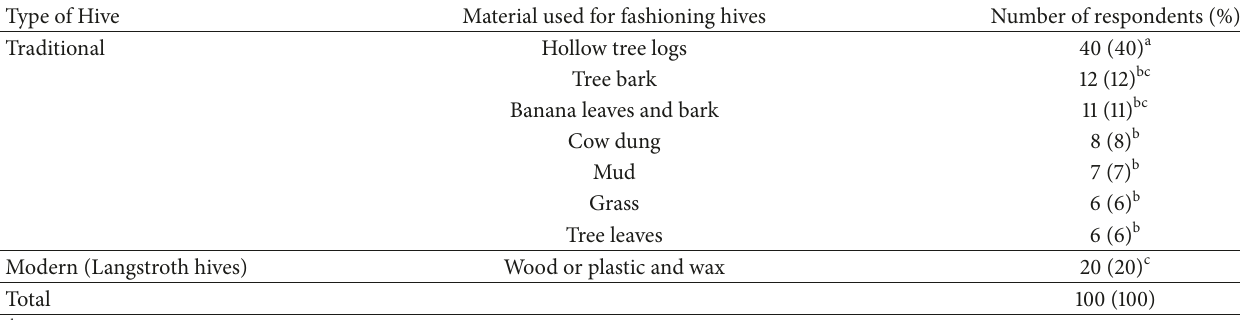
Table 3: Proportions of the types of hives used by beekeepers in Kayonza.